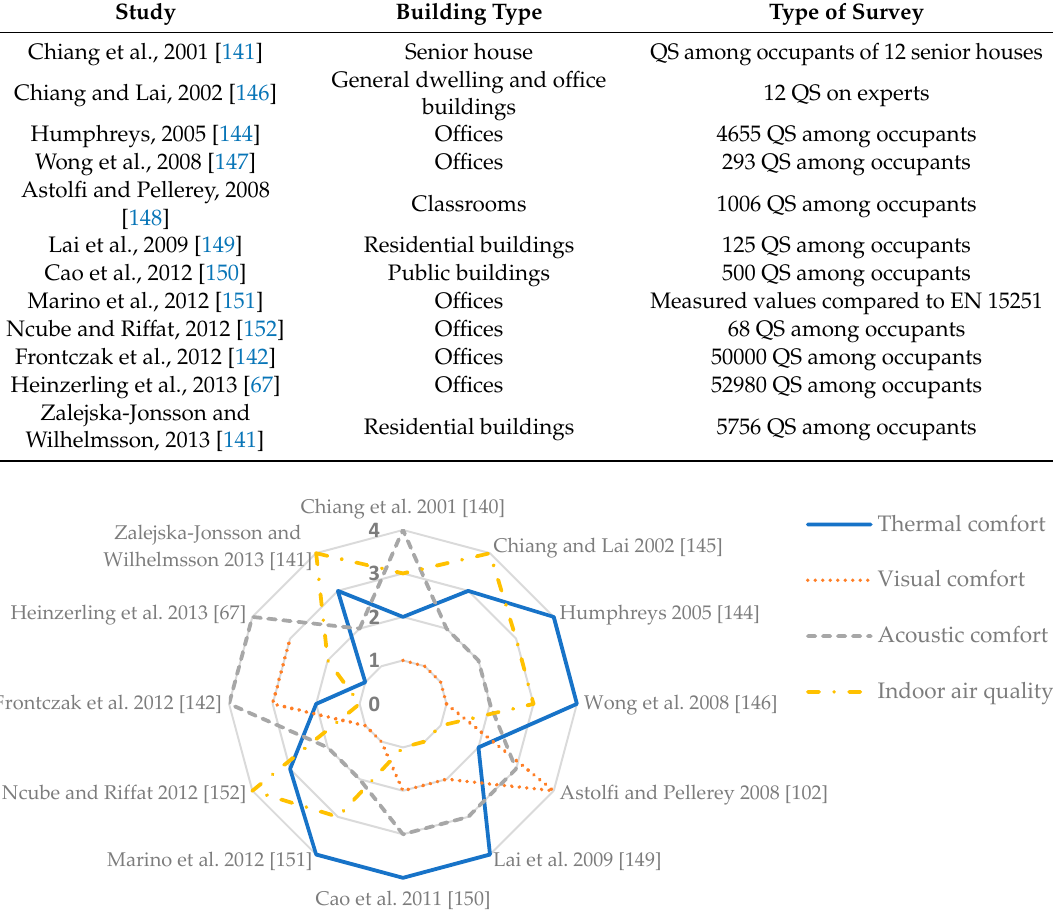
Table 2. List of studies that have created a ranking of importance of IEQ factors.